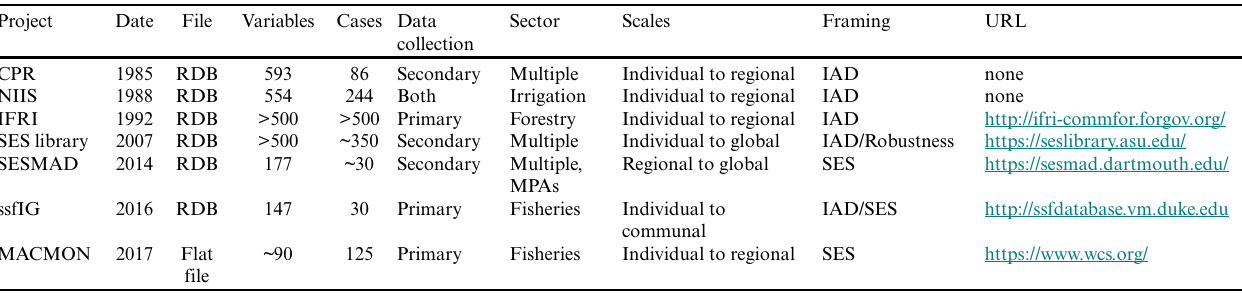
Table 1 . Summary of the projects arising from the workshop frameworks. File refers to the data format used to store the data (RDB = relational database, Flat = spreadsheet). Data collection refers to whether the data is collected in the field vs. collected from published sources. The databases are based on different frameworks, although because of commonalities among the workshop frameworks, this does not lead to as much divergence in data structures as one might